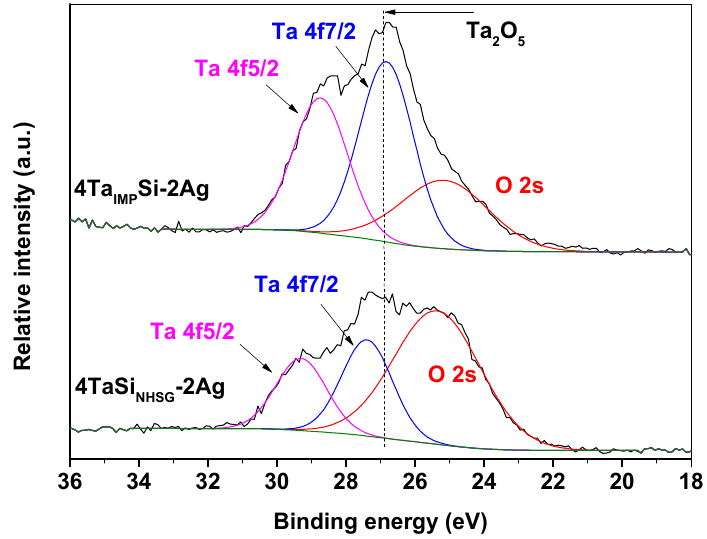
Figure 2. Binding energy shift of tantalum in XP spectroscopy spectra between Ta impregnated (4Ta IMP -2Ag) and Ta one pot (4Ta NHSG -2Ag).